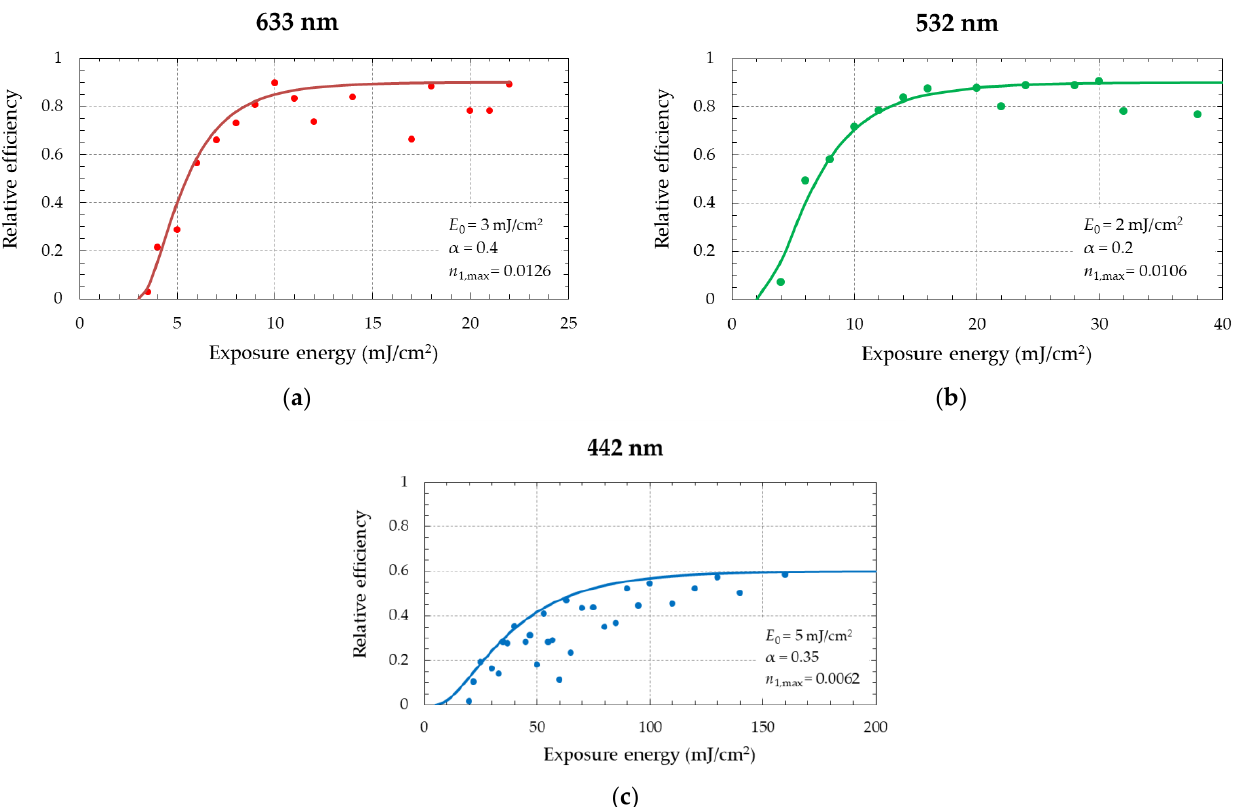
Figure 5. Efficiencies versus exposure and theoretical curve in the recording with each of the three wavelengths ( a ) 633 nm, ( b ) 532 nm and ( c ) 442 nm.